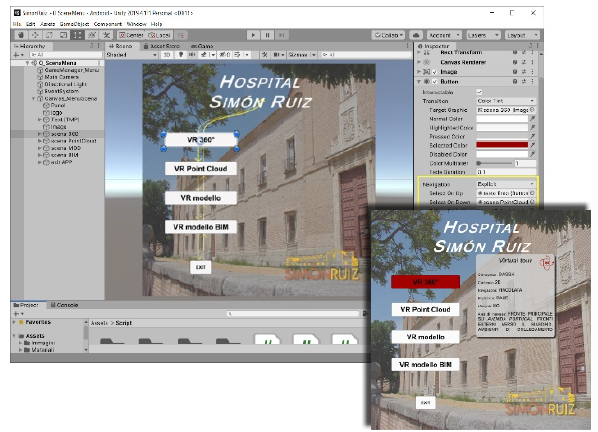
Figure 8: Start menu of the VR App . Selection of the key corresponding to the 360 ° Scene and display of the related graphic and textual